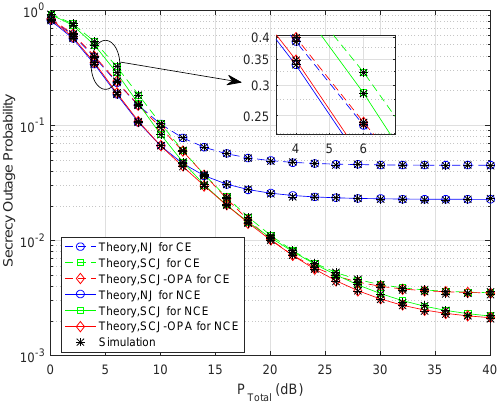
Figure 2. Secrecy outage probability vs. the total transmit power budget P Total for the three proposed transmission schemes when R s = 0.6 (bit/s/Hz), M = 3, L = 2, K =